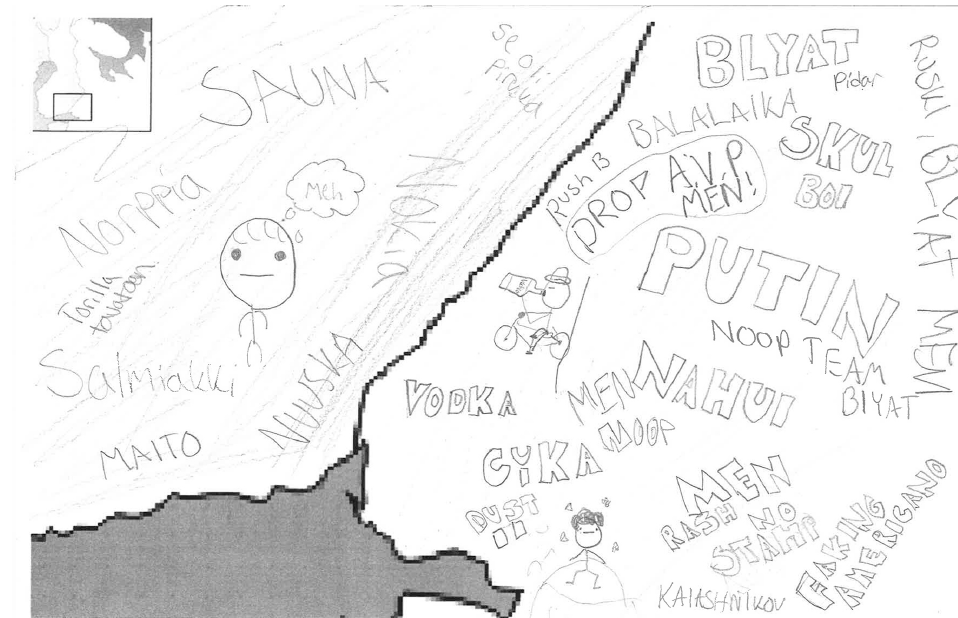
Fig. 1 . Old and new stereotypes of Russia and Russians meet in the map drawn by an eighth- class boy from a normal Finnish